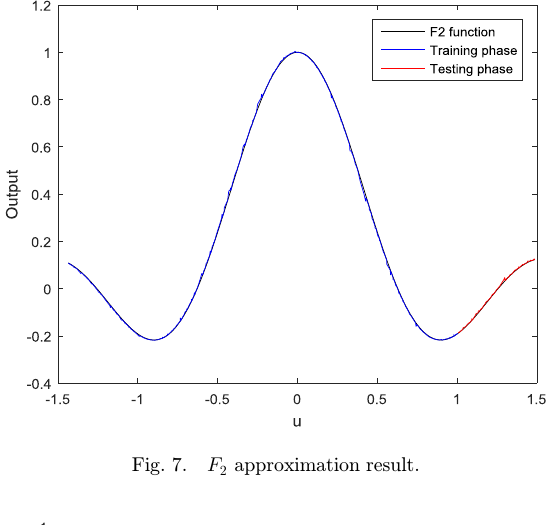
Fig. 7. F 2 approximation